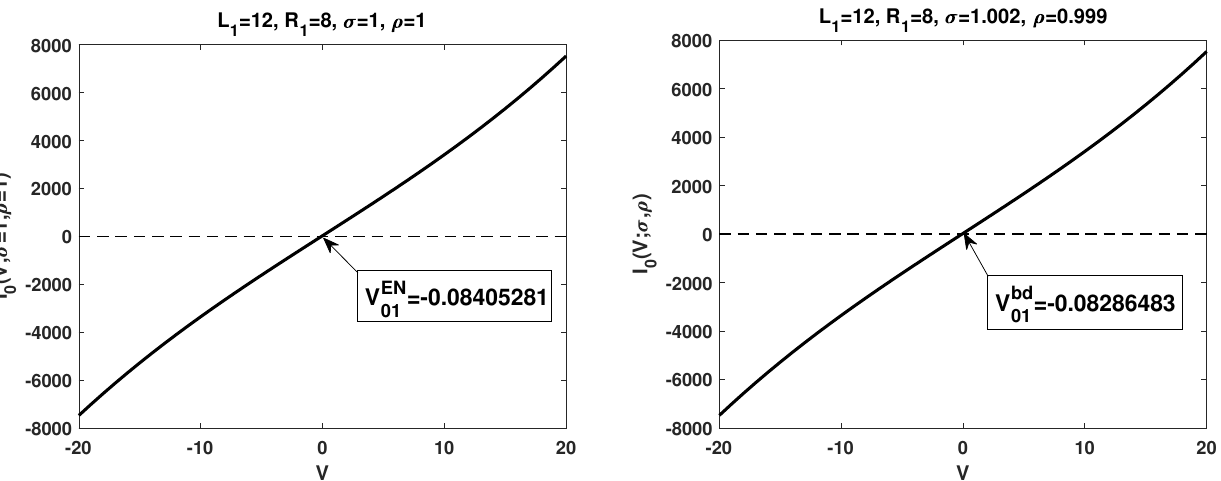
Figure 2. Numerical simulations of I 0 ( V ) , the zeroth-order I–V relations in Q 0 for two different setups. The left figure is under electroneutrality boundary conditions, while the right one is with boundary